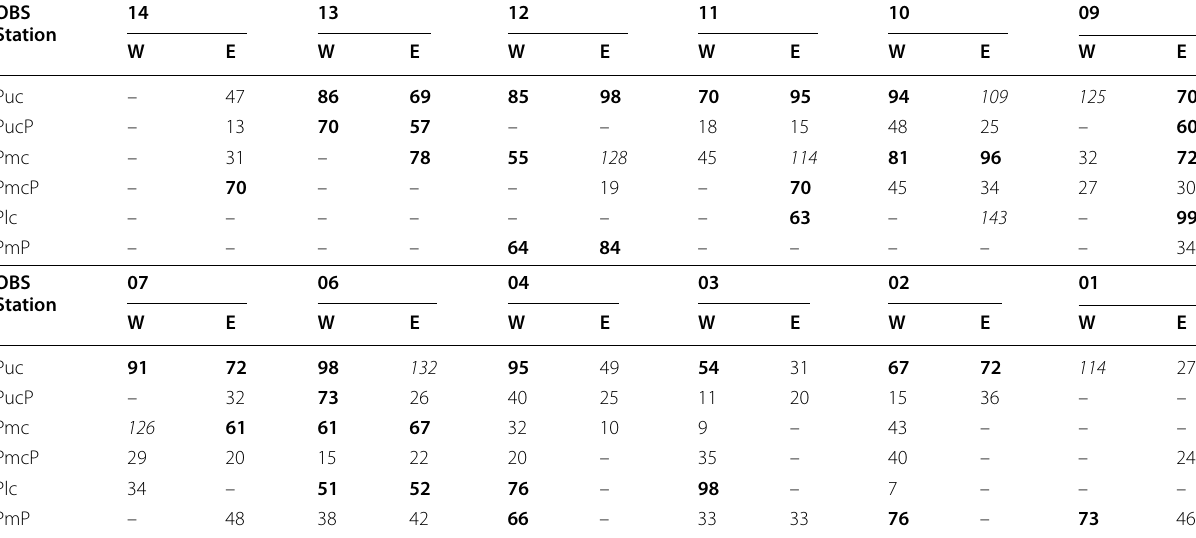
Travel-time errors of 50–100 ms and greater than 100 ms are denoted by bold and italics emphasis,